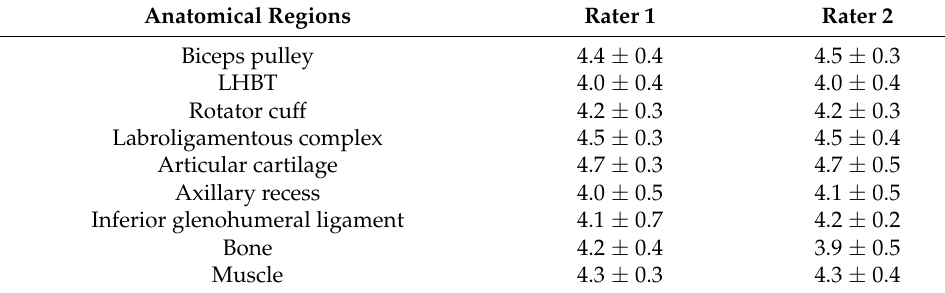
Table 4. Visibility of anatomical landmarks of the shoulder 1